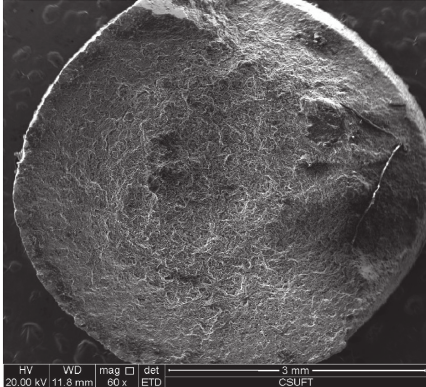
Figure 5: Photo of fracture section of gray cast iron specimen.